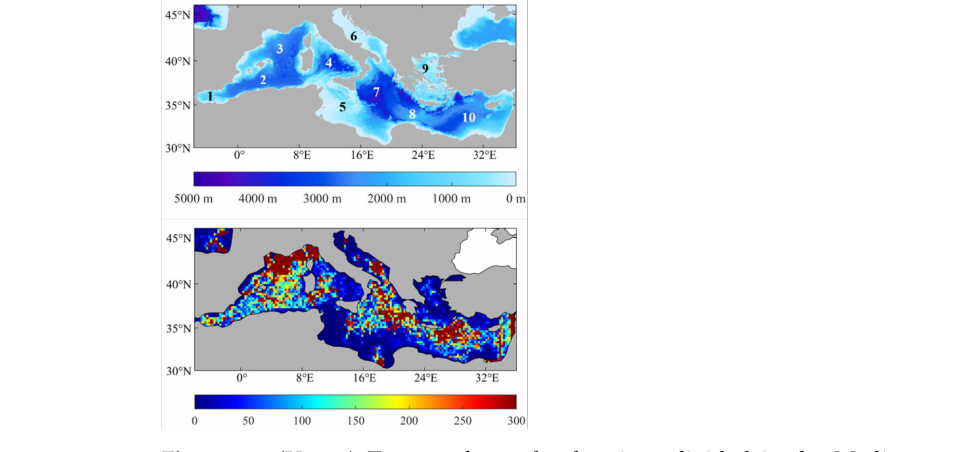
Figure 1. ( Upper ) Topography and subregions divided in the Mediterranean Sea, including zone1: Alboran Sea, zone 2: Algerian Sea, zone 3: Balearic Sea, zone 4: Tyrrhenian Sea, zone 5: Southern Mediterranean, zone 6: Adriatic Sea, zone 7: Ionian Sea, zone 8: Libyan Sea, zone 9: Aegean Sea and zone 10: Levantine Sea. ( Bottom ) Data volume of in situ SSS measurements in the Mediterranean Sea as obtained from profilers, buoys, glider, drifter, CTD provided by the World Ocean Database 18 and ship measurements provided by Global Ocean Surface Underway Data, which has been ingested by the CMEMS L4 SSS